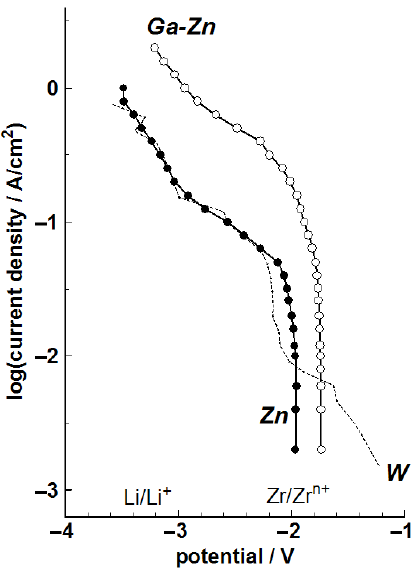
Figure 6. Polarization of liquid Zn and Ga–Zn cathodes in 3LiCl–2KCl–ZrCl 4 melts at 567 °C (0.89 wt. % ZrCl 4 ) and 550 °C (0.87 wt. % ZrCl 4 ), respectively. Potentials vs. 2Cl – /Cl 2 reference couple. Polarization curve for solid tungsten cathode is shown for comparison.